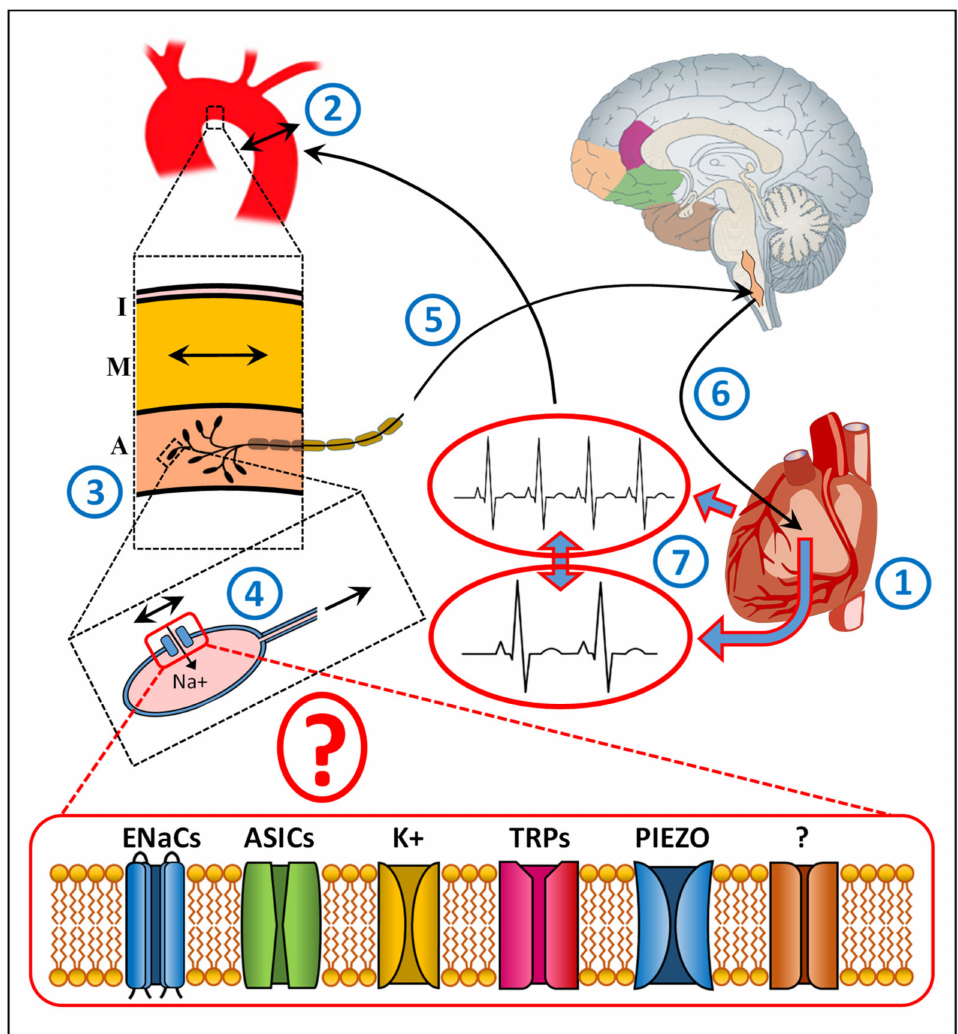
Figure 1. A schematic diagram illustrating the baroreceptor reflex of the aortic arch and the involve- ment of ion channels. The heart (1) regulates its rate according to the body’s needs. Changes in heart rate (1) alternate blood pressure. The corresponding changes exercise mechanical forces on the aortic wall (2). The changes in shear stress are sensed by specific mechanoreceptors, called baroreceptors, at the endings of sensory nerves innervating the outer wall (adventitia) of aortic arch (3). These mechanical deformations are affecting the mechanosensitive baroreceptors (4), assumed to be specific ion channels, which in turn provide an action potential in the corresponding nerve terminal, which is propagated along the afferent nerve fibers (5) toward the nodose ganglia in the brainstem. The